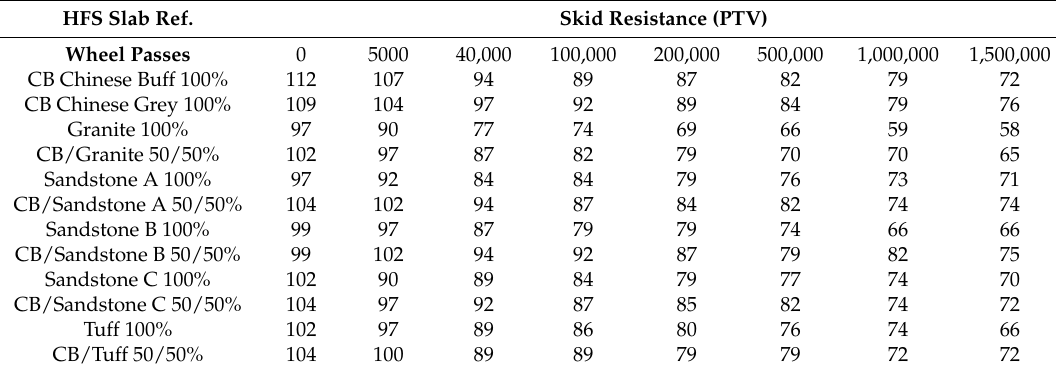
Table 2. Skid resistance data up to 1.5 million wheel-passes (Aetec data). HFS Slab